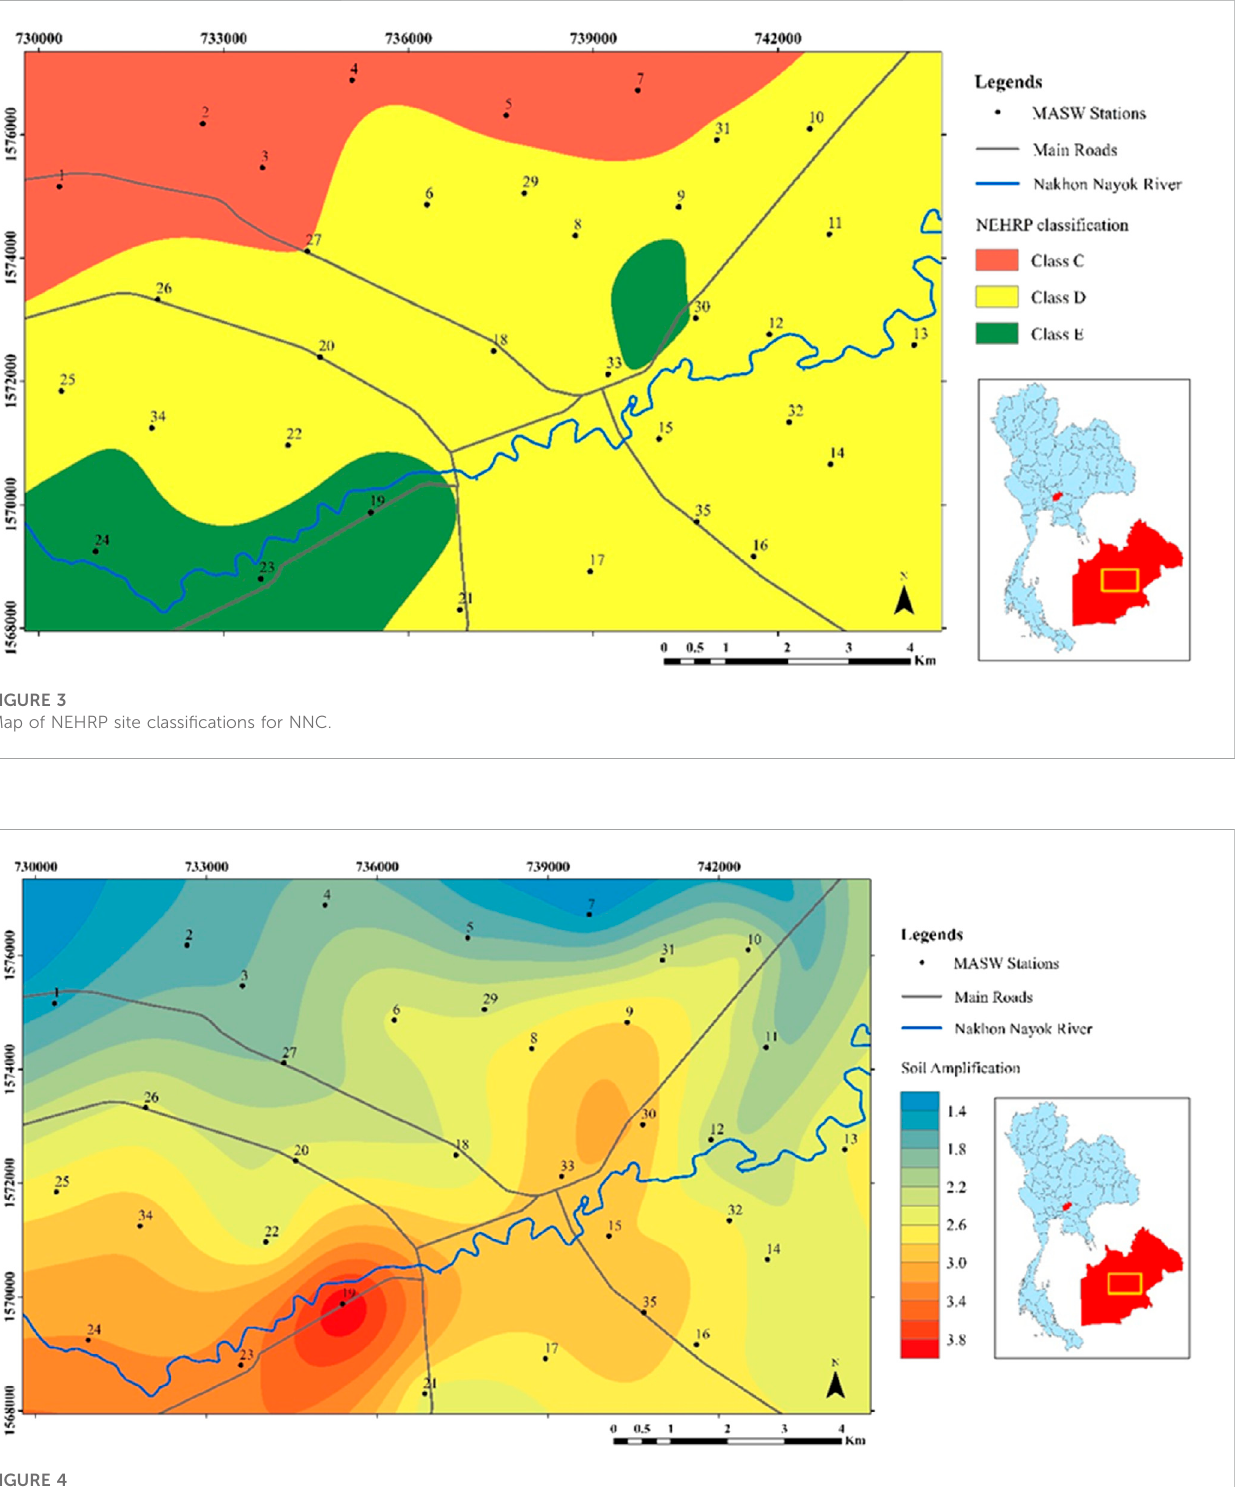
Preliminary soil ampli fi cation map of